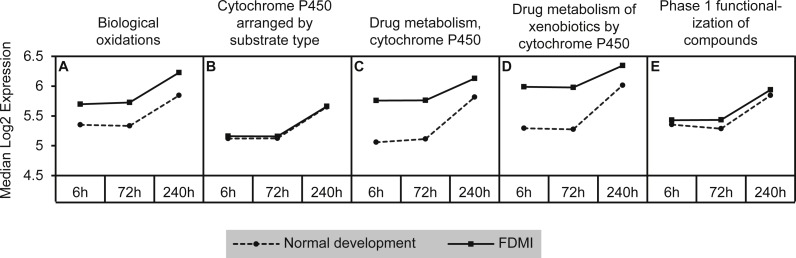
Median expression of pathways involved in cytochrome p450 metabolism.Graph indicates enhanced expression in cytochrome p450 related pathways in FDMI compared to normal development. (A) Biological oxidations (B) Cytochrome P450 arranged by substrate type (C) Drug metabolism, cytochrome P450 (D) Drug metabolism of xenobiotics by cytochrome P450 (E) Phase 1 functionalization of compounds.